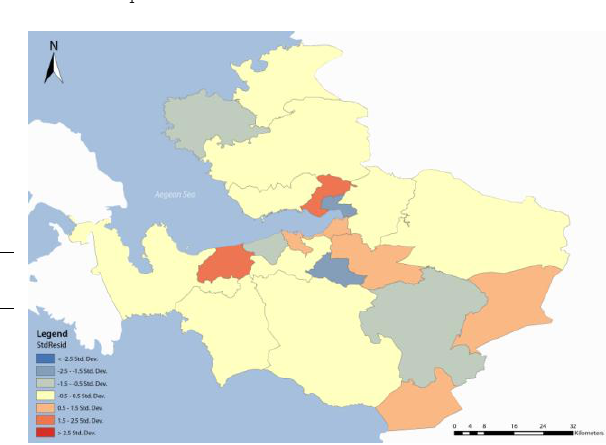
Figure 4. Map of GWR at district scale In Figure 4 deviations from the model in Equation 2 is plotted for each district. Considering the GWR at district scale, distance from education and number of public transportation stations, wind speed and all the socio-economic variables are 95% significantly explain robbery in the study area. At the north and south parts of the study area even 99.5% significant relationship is calculated. At the northwest-southeast direction significance level is partially decreases. On the other hand, some variables like temperature, distances from bank, commerce and police station, has no explanatory significance on robbery at district scale. We concentrated our grid scale analysis to the mostly populated area. Determining the explanatory variables of robbery for grid scale, grid cells are used. Grid cell size is defined as 400x400 m and this superimposed on the study area which is shown in Figure 5. This size is not small enough for predicting the future Table 2. Descriptive statistics for explanatory variables at crime with exact location, but it is enough to give an opinion district scale (n=21) about the risky locations in the study area. Grid cell midpoint coordinates are used to measure the distance away from the facilities such as DB, DC, DE and DS. NT is the count of the public transportation stations in a grid cell. POP is a total housing population in a grid cell which is computed from land use map per building. SG, AM and M are attained from obtained district level data according to household population in a grid cell. T and W are the averages of assigned robbery meteorology values,